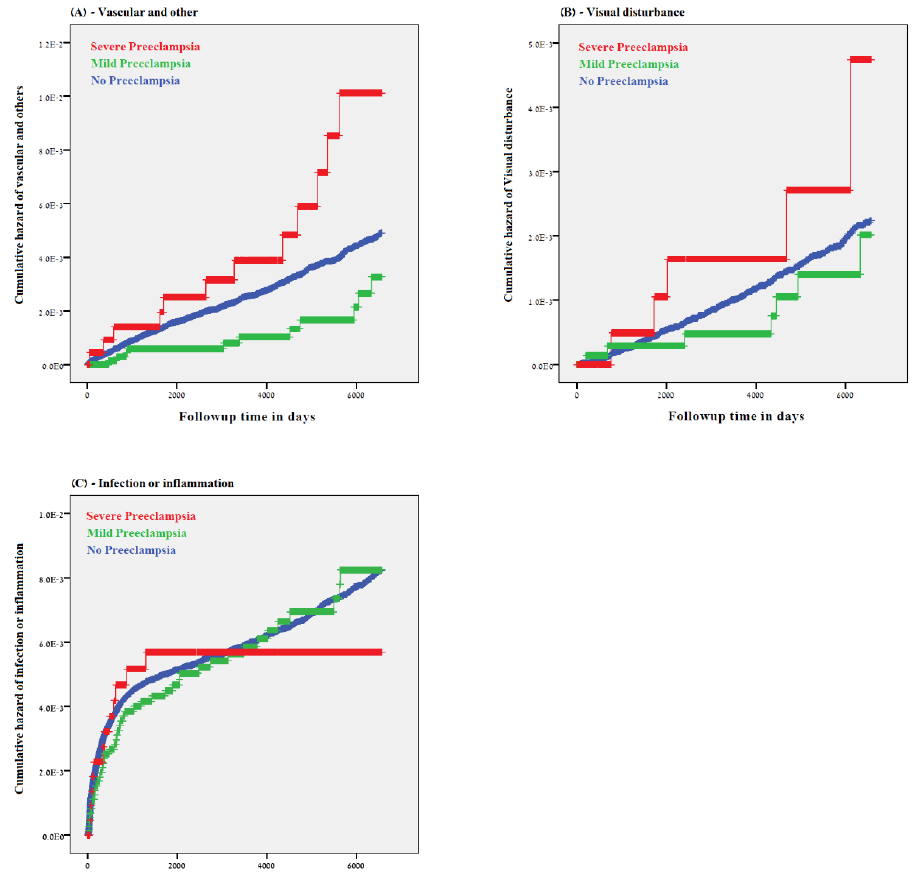
Figure 3. Kaplan–Meier curves demonstrating the cumulative incidence of long-term ophthalmic morbidity in offspring exposed to preeclampsia for each subcategory outcome: vascular and other ( A ), Log-rank test, p = 0.007, visual disturbance ( B ), Log-rank test, p = 0.303, and infection and inflammation ( C ), Log-rand test, p = 0.881. Table 3. Multivariable analyses of long-term total ophthalmic morbidity and vascular and other morbidity in o ff spring prenatally exposed to